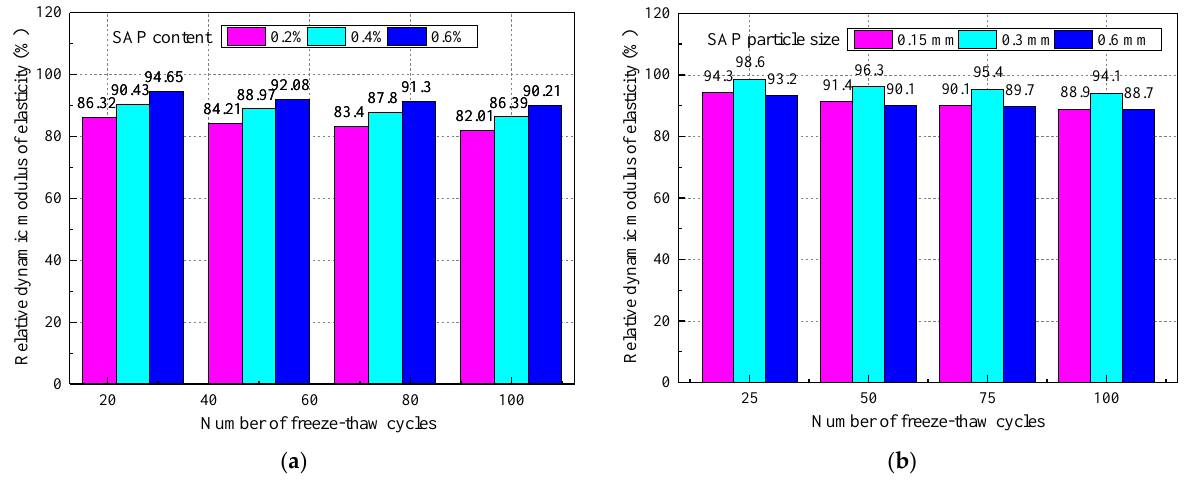
Figure 13. The influence of SAP on the relative dynamic elastic modulus of concrete: ( a ) SAP particle size of 0.3 mm; ( b ) SAP content of 0.4%.